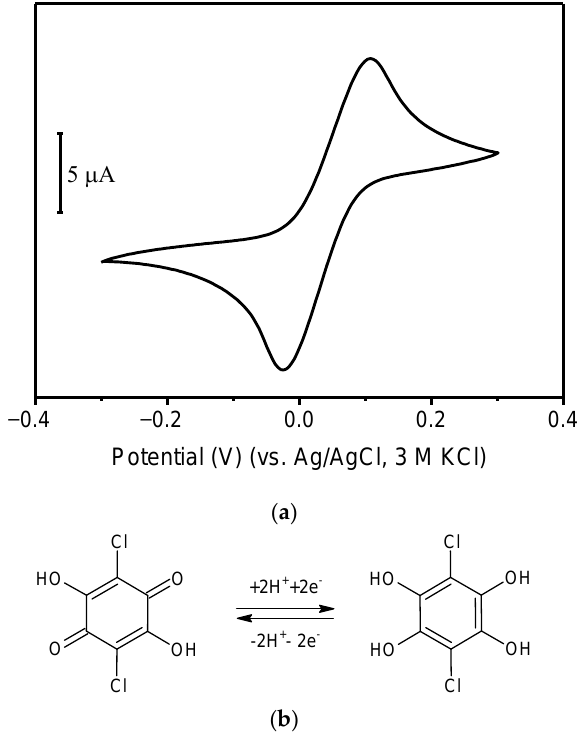
Figure 8. ( a ) CV voltammograms recorded for a solution containing 0.5 mM of chloranilic acid and 0.1 M of acetic acid using a glassy carbon electrode (d = 3 mm). Scan rate: 50 mVs − 1 . ( b ) Electroreduction of chloranilic